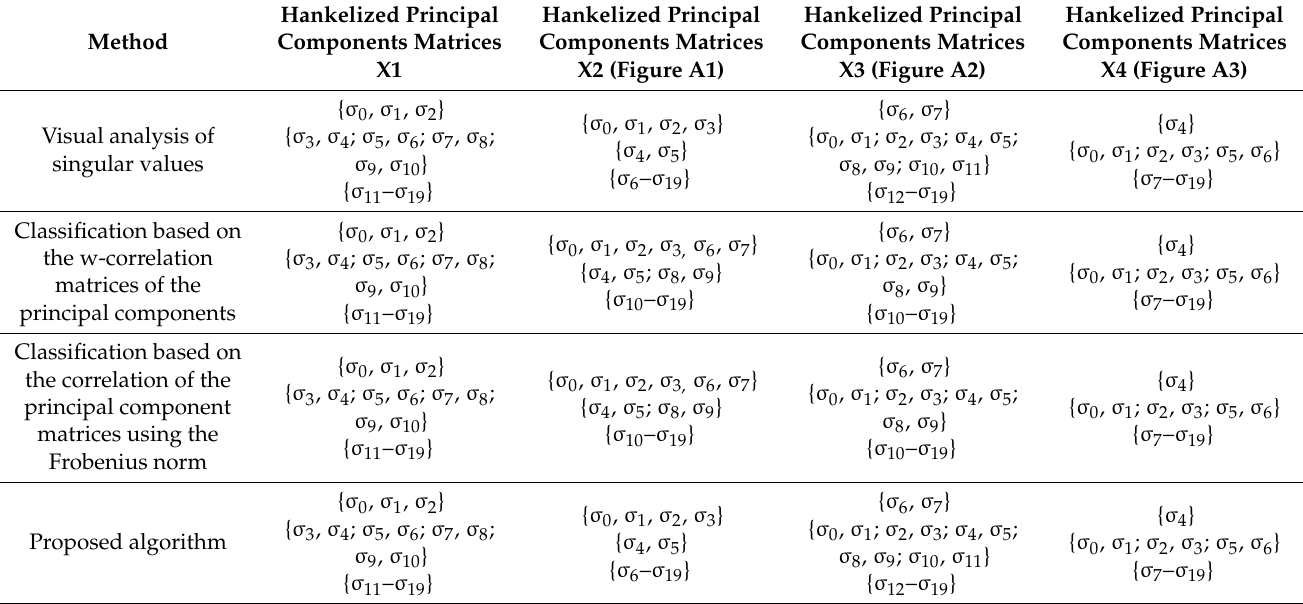
Table 4. Comparison of the results of component grouping by the considered methods for different tests.